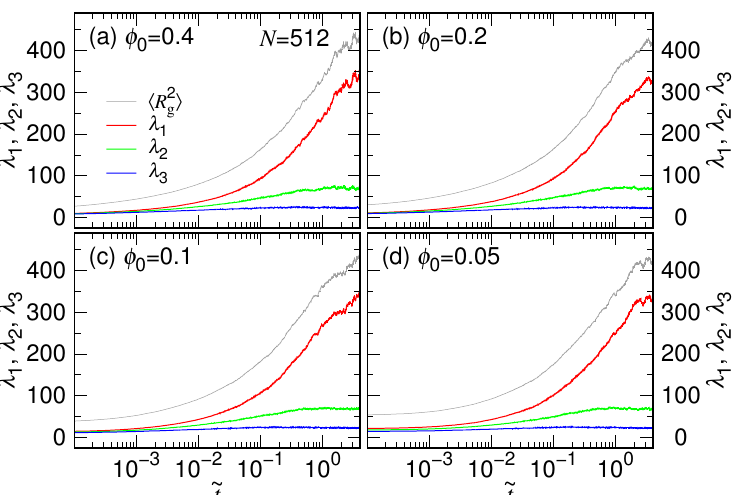
Figure 10. Eigenvalues λ 1 , λ 2 , λ 3 of [ G ] as a function of ˜ t for N = 512, released from ( a ) φ 0 = 0.4, ( b ) φ 0 = 0.2, ( c ) φ 0 = 0.1, and ( d ) φ 0 = 0.05. The The color representations of the curves are given in Panel ( a